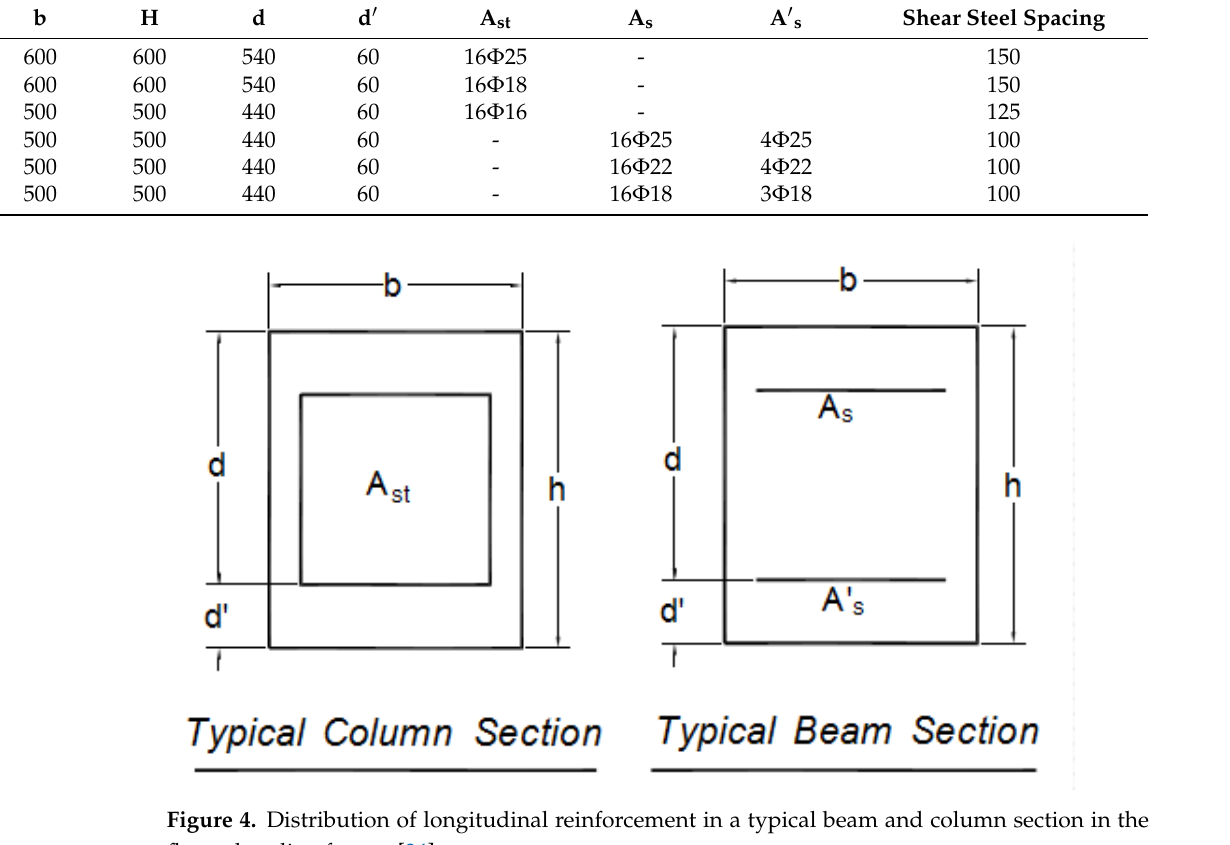
Figure 4. Distribution of longitudinal reinforcement in a typical beam and column section in the flange-bonding frames [34].